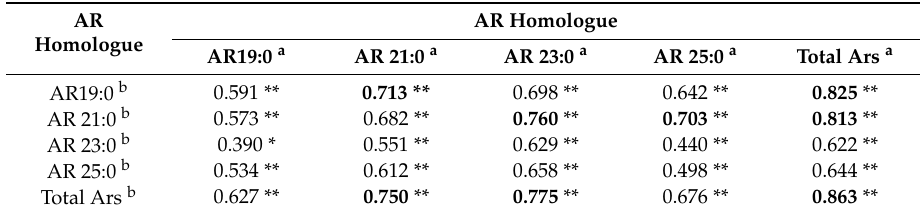
Table 3. Correlation coefficients between total ARs, AR homologue content on seed surfaces and that in whole